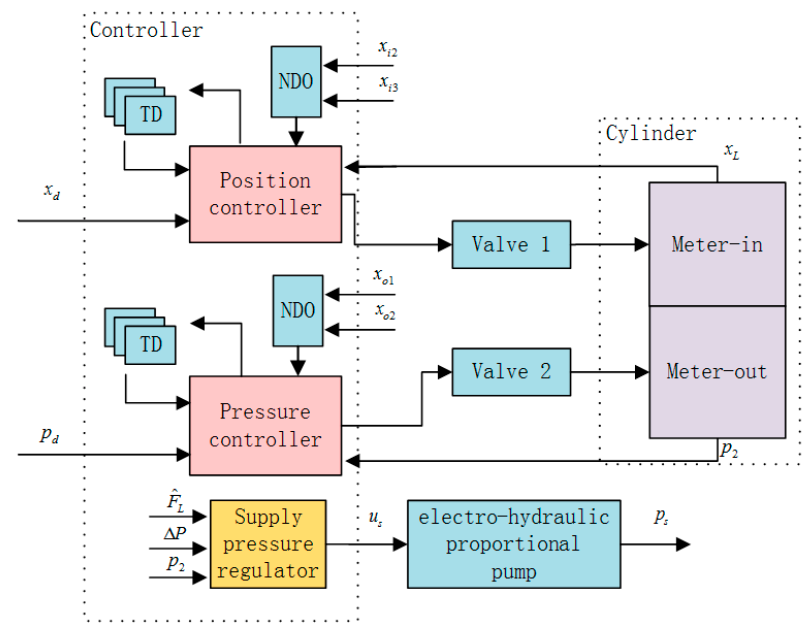
Figure 5. Schematic of the controller.